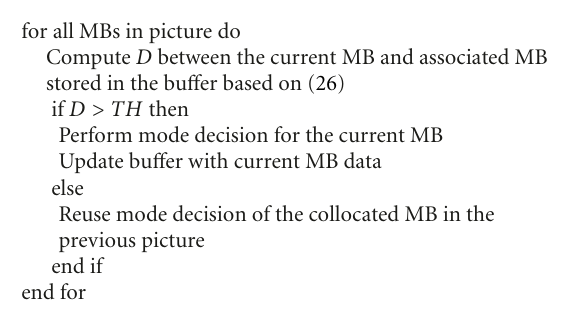
Algorithm 1: Mode decision based on temporal